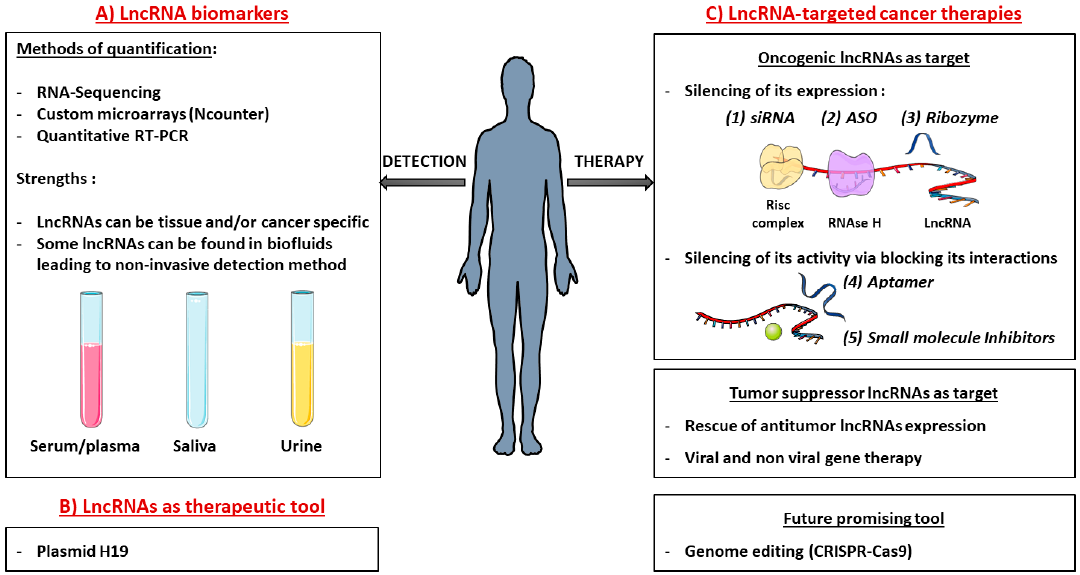
Figure 3. LncRNAs in clinic: ( A ) lncRNA biomarkers. High throughput technologies are used to quantify lncRNAs and highlight their prognostic potential. LncRNAs are promising predictive biomarkers as their expressions can be highly tissue and / or cancer specific. Some of them are even present in biofluids allowing an easy and non-invasive detection method. ( B ) LncRNAs as a therapeutic tool. Highly cancer-specific, lncRNAs can be used as tools to selectively kill tumor cells. For example, a plasmid containing diphtheria toxin under the control of H19 regulatory sequences has been designed to selectively target tumor cells which overexpressed H19 compared to normal cells. Diphtheria toxin is massively produced and selectively kills H19-overexpressing tumor cells. ( C ) LncRNAs targeted cancer therapies. Oncogenic LncRNAs as target: silencing of its expression: ( 1 ) Small interfering RNA (siRNA) are double-stranded RNA oligonucleotides antisense and complementary to target lncRNA sequences. They induce degradation of their target by recruiting the RISC (RNA-induced silencing) complex. ( 2 ) An antisense oligonucleotide (ASO) is a single-stranded DNA oligonucleotide that is complementary to the target RNA and able to induce its degradation by recruiting RNase H. ( 3 ) Ribozymes (Ribonucleic acid Enzymes) are single-stranded RNA. By adopting specific conformations, they are able to bind RNA targets and catalyze their degradation. Oncogenic LncRNAs as target: silencing their activity: Small molecules are also able to hide partners’ interaction sites (DNA, RNA, proteins) to suppress their activities. ( 4 ) Aptamers are single stranded DNA folded into secondary and tertiary structures that can bind specific structural regions of the target lncRNAs. ( 5 ) Small molecule Inhibitors can also disrupt lncRNA interactions. Tumor suppressor lncRNAs as target: Rescue of its expression: It can be provided by common gene therapy strategies, packaging the whole transcript into viral or non-viral delivery tools. Future promising tool: ( J ) New Genome editing strategies such as CRISPR / Cas9 are developing very fast to knock-in / out lncRNA